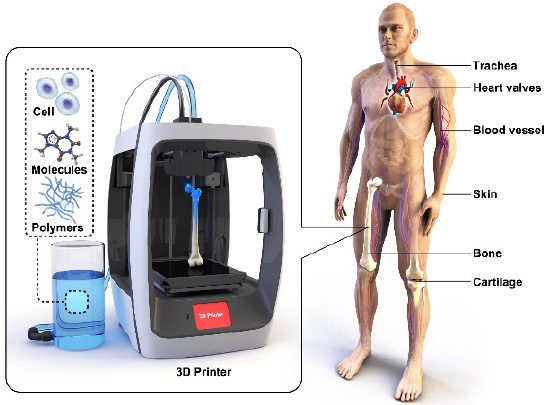
Figure 28. Various scaffolds for tissue engineering obtained by AM technologies [173].